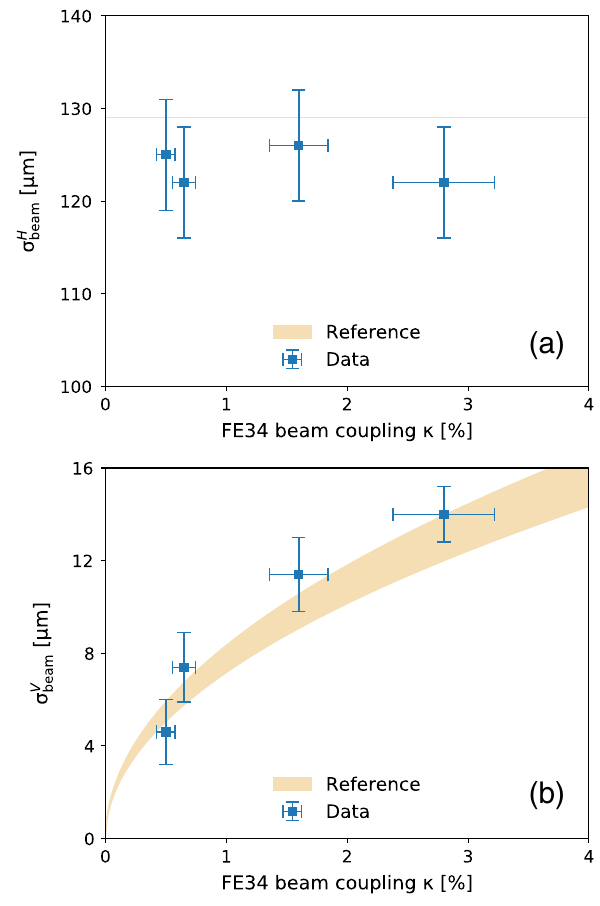
FIG. 11. Measured horizontal (a) and vertical (b) beam sizes as a function of the beam coupling measured at FE34. Expected values based on independent pinhole and LOCO measurements are also reported for comparison.